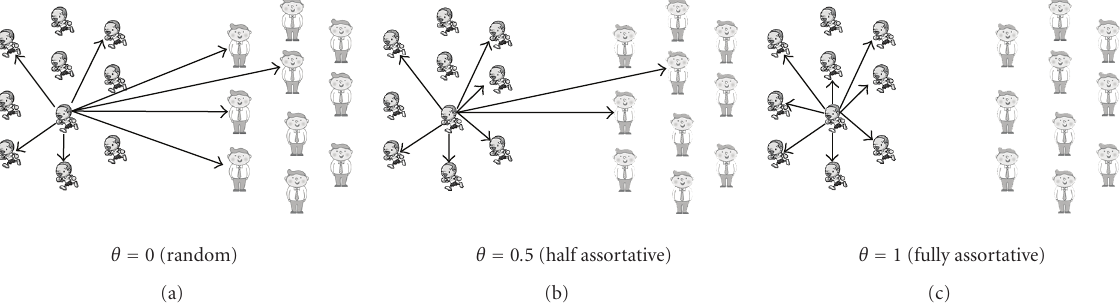
Figure 2: Preferential mixing given a single child index case. The hypothetical population consists of 10 children (left) and 10 adults (right) with equal susceptibility and infectiousness. We consider an introduction of a single child index case who has a potential to cause 8 secondary transmissions.Panels (a)–(c) illustrate contacts generated by the child index case with di ff erent θ , proportion of within-group contacts, being 0, 0.5 and 1.0, respectively. With θ = 0 (i.e., random mixing), four edges extend to child susceptibles and the other four to adult susceptibles. Nevertheless, with θ = 0 . 5, additional two edges are reserved for within-child mixing and only the remaining two are connected to adult susceptibles. With θ = 1 (i.e., fully assortative mixing), all edges are connected with child susceptibles.